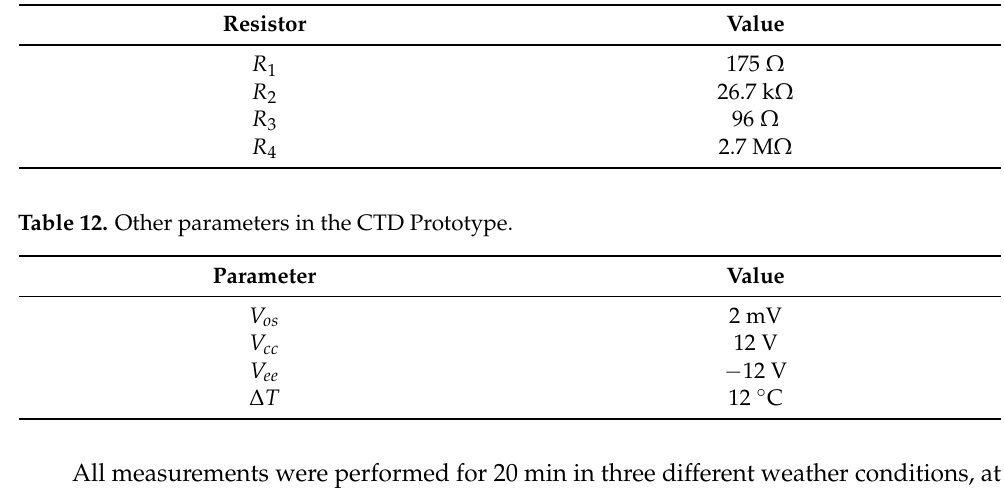
Table 11. Wheatstone bridge fixed resistors in the CTD Prototype.